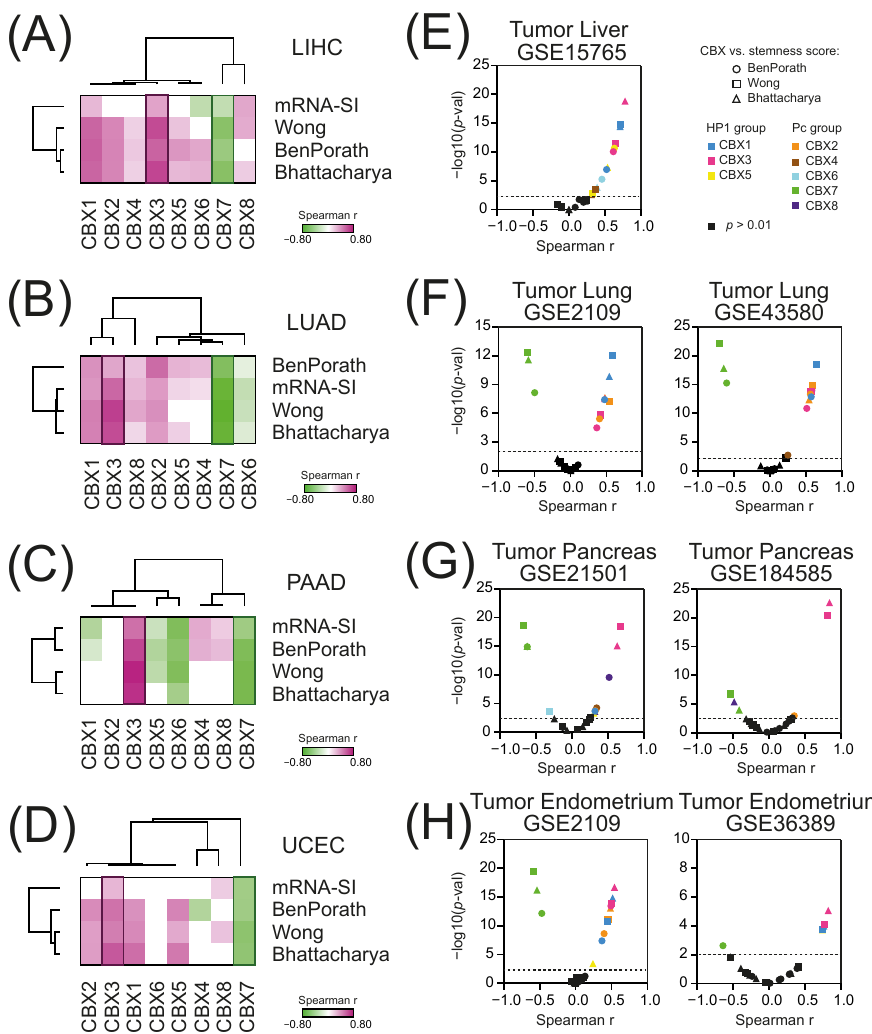
Figure 5. The correlation of CBX family members expression with cancer stemness. ( A – D ) The heatmaps of Spearman’s correlation between CBXs’ expression and four distinct stemness indices (mRNA-SI, Ben-Porath signature, Wong signature, Bhattacharya signature) in ( A ) LIHC, ( B ) LUAD, ( C ) PAAD, and ( D ) UCEC tumors. Purple and green denote either positive or negative correlation, respectively. Only statistically significant associations are shown ( p < 0.05). ( E – H ) The correlation of CBX expression with cancer stemness scores in several additional datasets for ( E ) liver, ( F ) lung, ( G ) pancreatic, and ( H ) endometrial tumors. CBX members are color-coded as presented in the legend. Circles, squares, and triangles encode for Ben-Porath, Wong, and Bhattacharya signatures, respectively. Statistically insignificant correlations are colored in